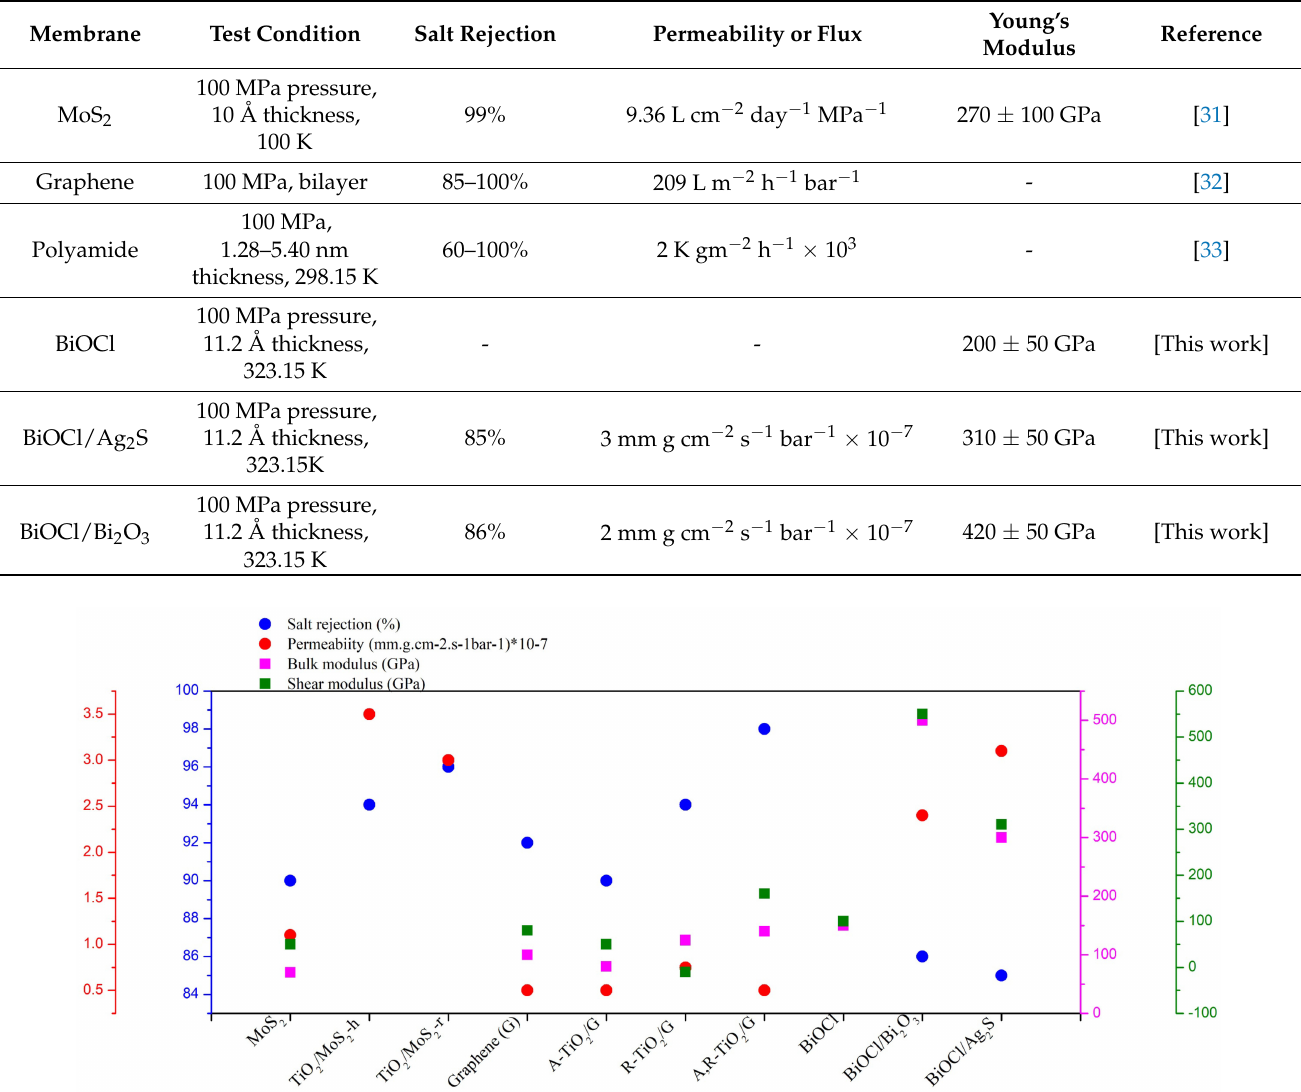
Figure 11. Salt rejection (blue), permeability (red), bulk modulus (magenta), and shear mod- ulus (green) under 100 MPa pressure. Ps: MoS 2 , TiO 2 /MoS 2 -h, TiO 2 /MoS 2 -r [29], graphene, A-TiO 2 /graphene, R-TiO 2 /graphene, A-RTiO 2 /graphene